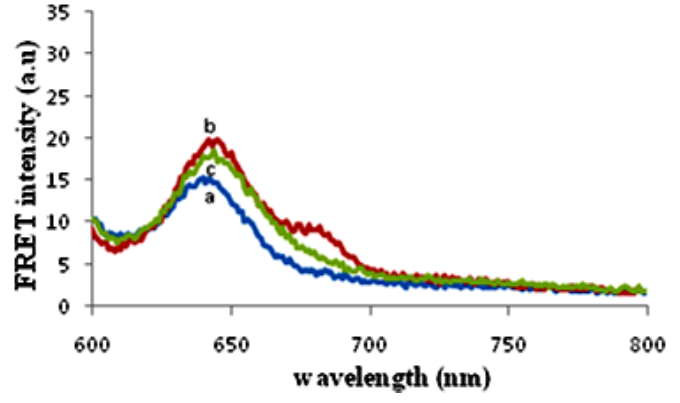
Figure 1. Fluorescence spectra of ( a ) CdSe quantum dot (QD)-ssDNA, ( b ) CdSe QD-ssDNA hybridized with complementary DNA and ( c ) CdSe QD-ssDNA hybridized with non-complementary DNA; Excitation was fixed at 488 nm; scan rate: 2 nm/s; slidwidth: 10 nm.